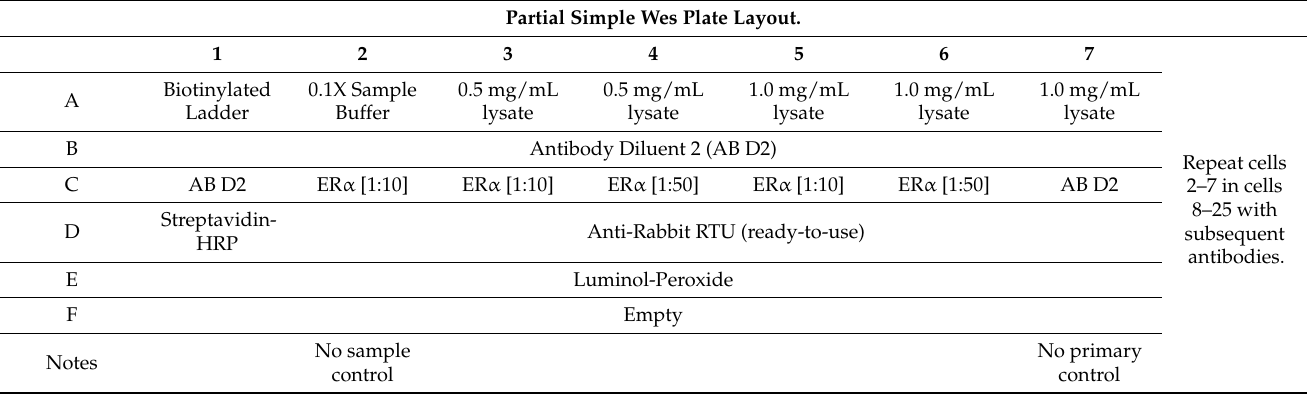
Table 1. Sample plate layout for the WES allowing us to determine optimal sample lysate and antibody concentrations, as well as verify antibody specificity. The plate layout designates six wells per sample with: a no-sample control, 0.5 mg/mL lysate—1:10 primary antibody, 1.0 mg/mL